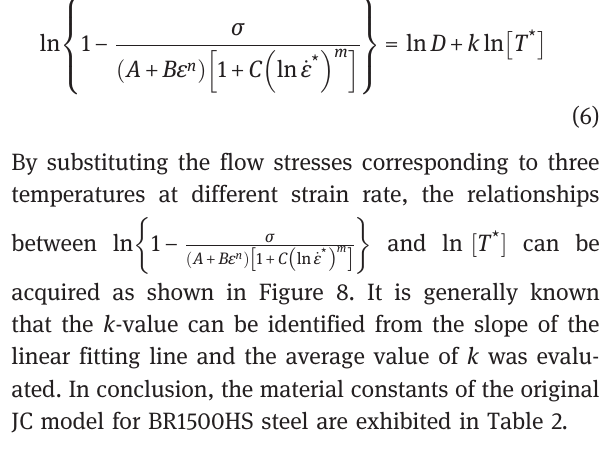
. n o ð A + B ε n Þ½ 1+ C ð ln _ ε * Þ m (cid:2) and ln ½ T * (cid:2) at the strain rates of: (a) _ ε =0.01s − 1 , (b) _ ε =0.1s − 1 ,